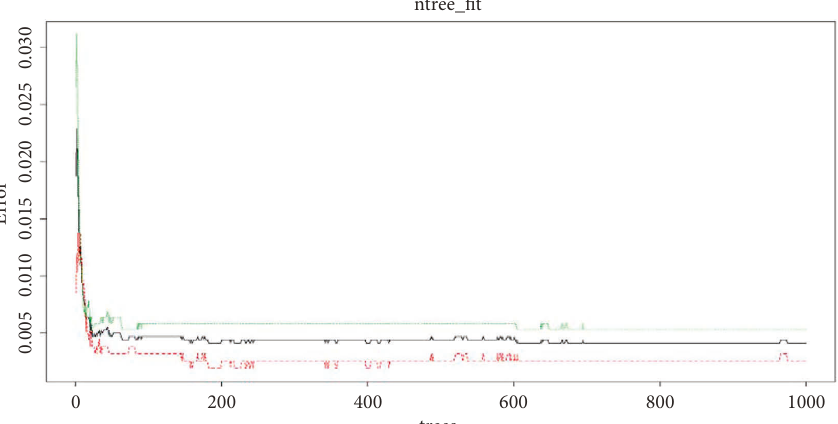
Figure 1: Results of mtry value traversal for random forest parameter search.